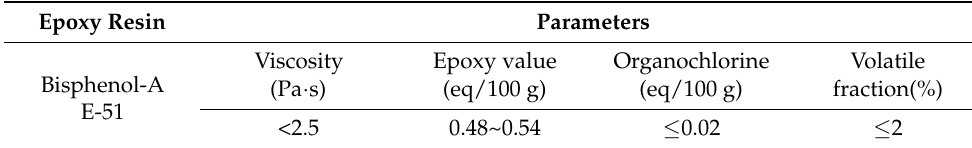
Table 1. The parameters of epoxy resin (Bisphenol-A E-51).